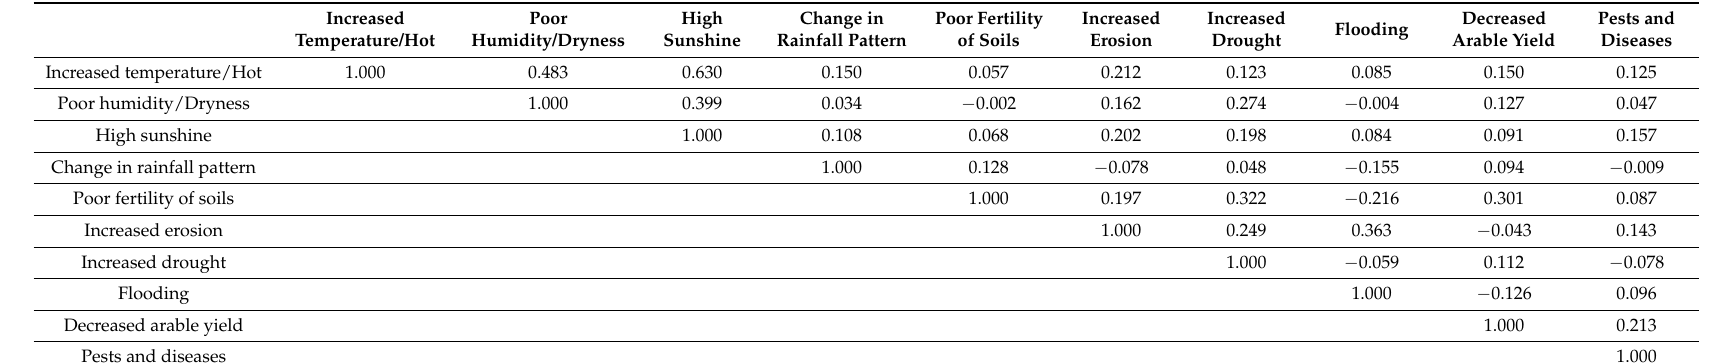
Table A1. Correlations matrix between perception variables.